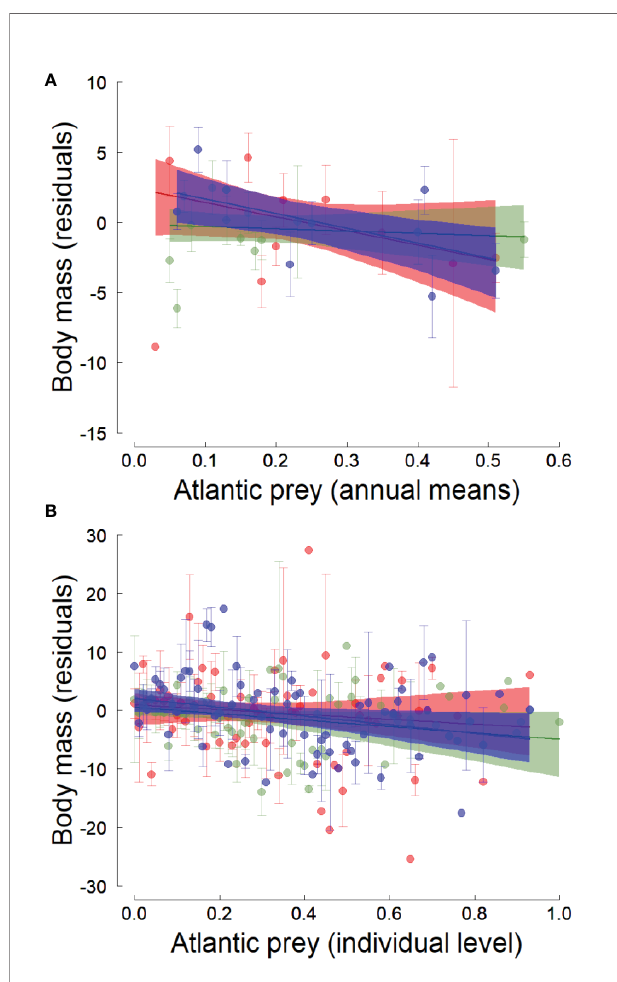
FIGURE 3 | Effect of the proportion of Atlantic prey in little auk chick diet on adult residual body mass in three western Svalbard fjords (green: Hornsund, blue: Isfjorden, red: Kongsfjorden). The residual body mass is the body mass adjusted for body size (i.e. residuals from a linear regression), which can be interpreted in terms of body condition. In (A) , the relation is between the average annual proportions of Atlantic prey and the little auk body mass, while in (B) the relation is at the individual level and represents the link between the individual proportion of Atlantic prey and the bird body mass. The lines are the regression lines from linear regressions and the shaded areas represent the bootstrapped 95% con fi dence intervals of the predicted values. Error bars represent the standard errors of the average body masses.